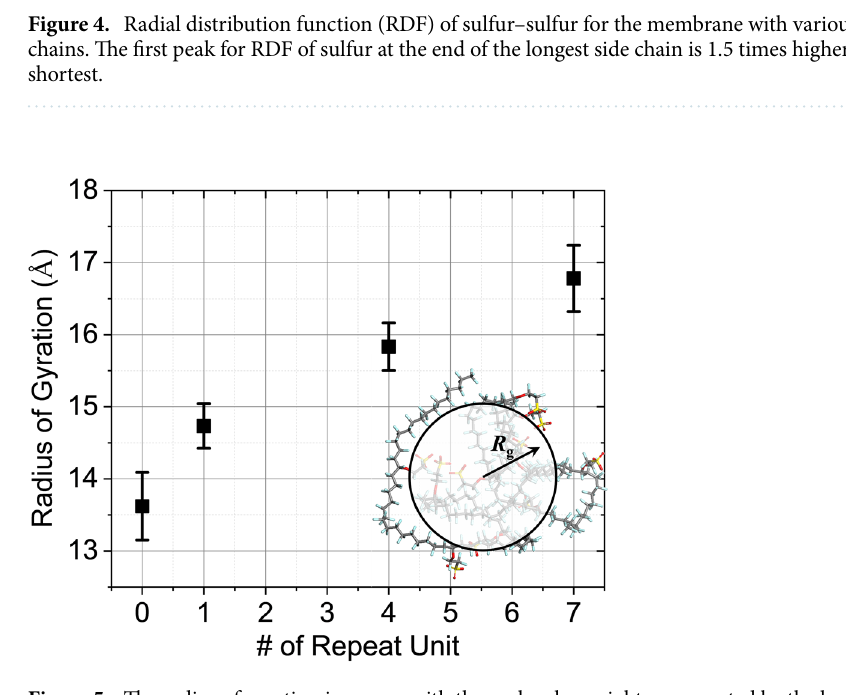
Figure 5. The radius of gyration increases with the molecular weight, represented by the length of side chain. The longer side chain with a stronger hydrophilic group has higher R g than shorter side chains because of the hydrophobicity of the